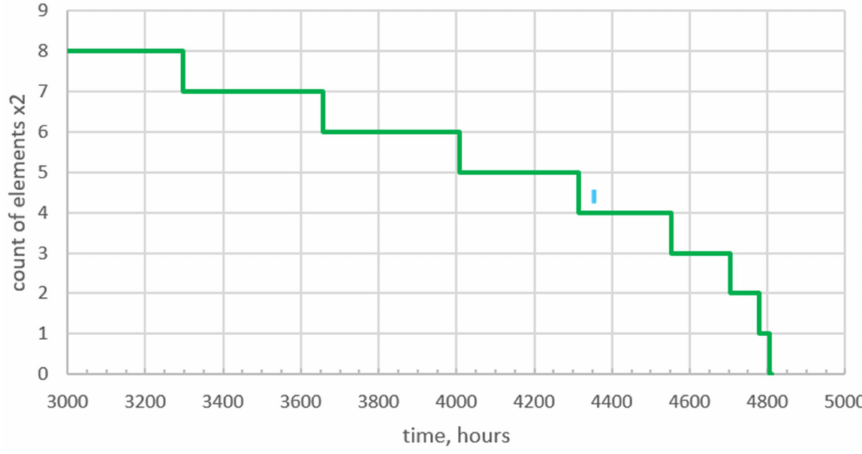
Figure 10. A fragment of a histogram of the hierarchical ramified system’s operation in the course of ( 1 ) = 7, a ( 2 ) = time for a 2 2